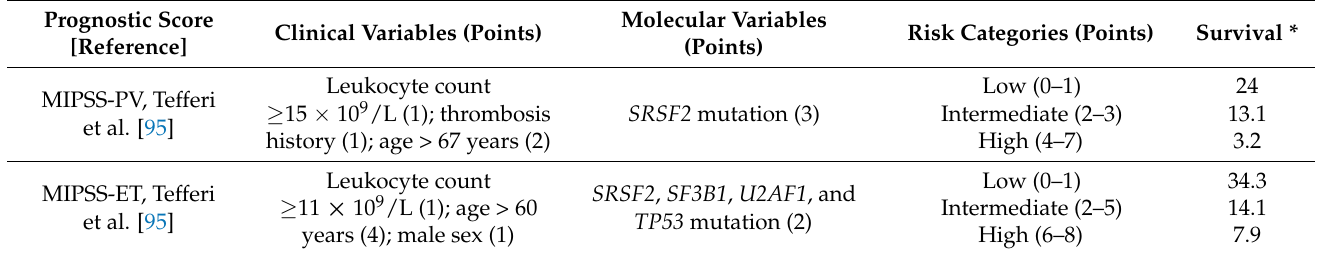
Table 3. Clinical-molecular prognostic scores in polycythemia vera and essential